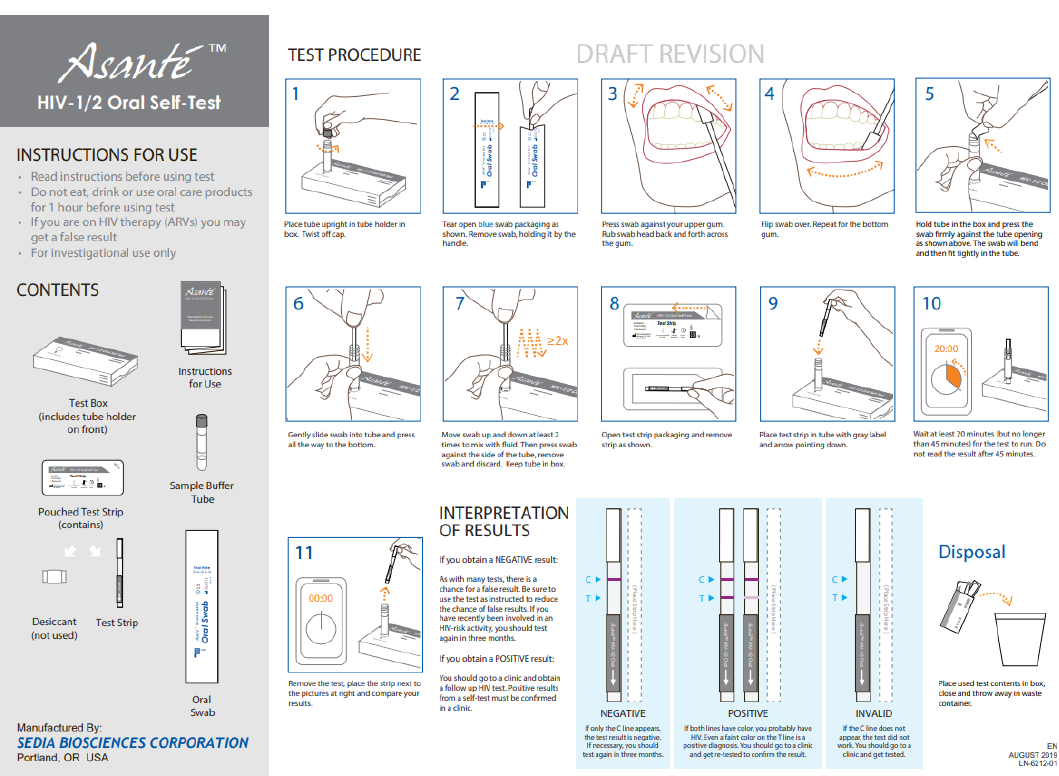
Figure A2. Asante™ HIV-1/2 Oral self-test used in Senegal.